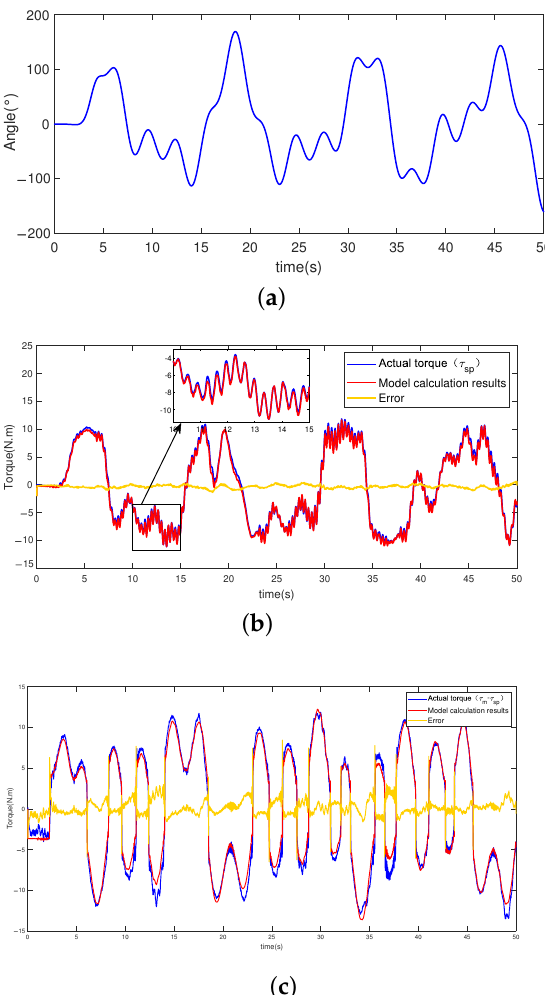
Figure 14. Model validation results. ( a ) Trajectory; ( b ) Comparison of model output torque and actual torque (link side); ( c ) Comparison of model output torque and actual torque (motor